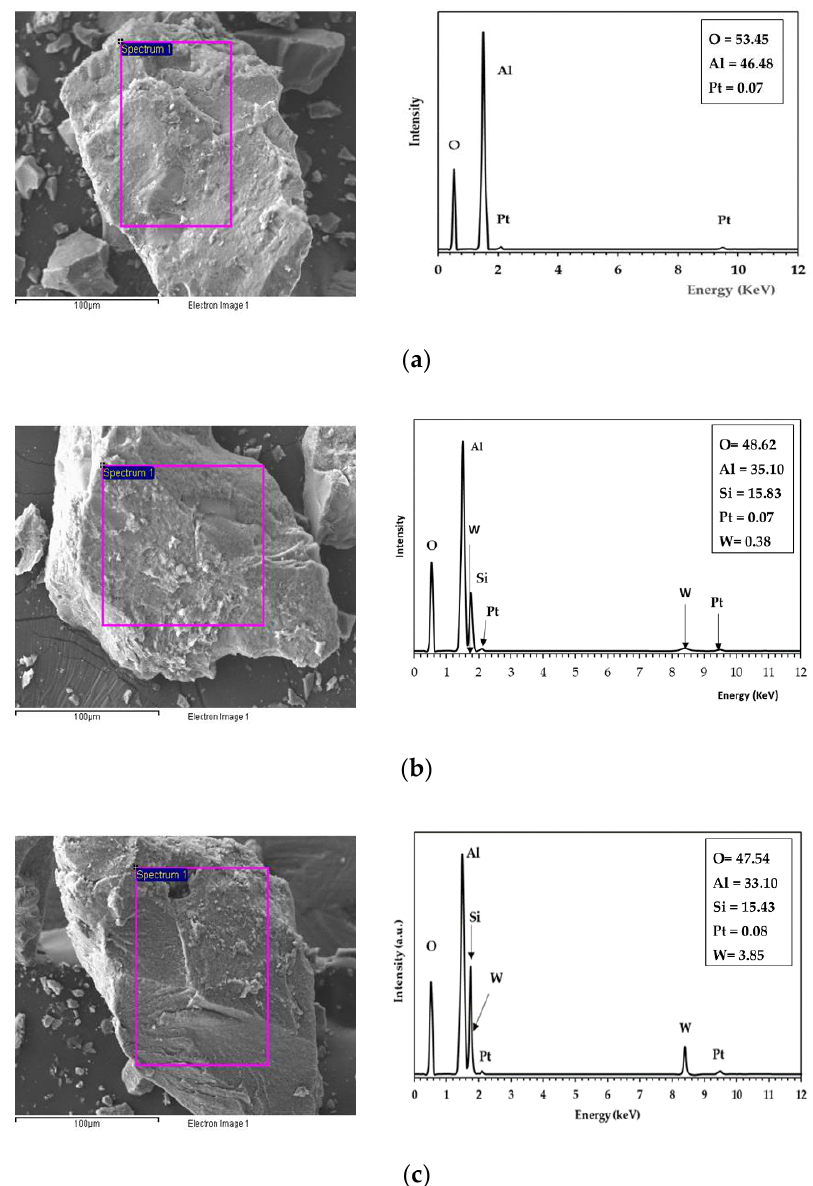
Figure 8. SEM photomicrographs and EDS analysis of the catalysts: ( a ) Pt100A, ( b ) Pt25SA‒0.5W, and ( c ) Pt25SA‒4W. The composition in weight percent was inserted in the upper inset.